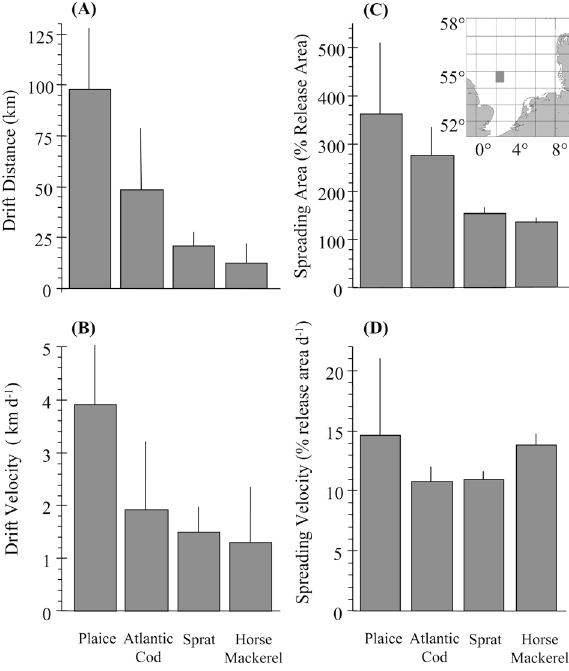
F IG . 4. – Summary characteristics of the dispersion of eggs and yolk- sac larvae of plaice, Atlantic cod, sprat and horse mackerel released on 1 January, 15 March, 15 May and 15 July respectively at Dogger Bank (North Sea). Values of mean drift distance (panel A), drift velocity (panel B), relative spreading area (panel C) and spreading velocity of particles (panel d) are means(+SE) of the results of re- leases made in five years (1988, 1989, 1995, 1996 and